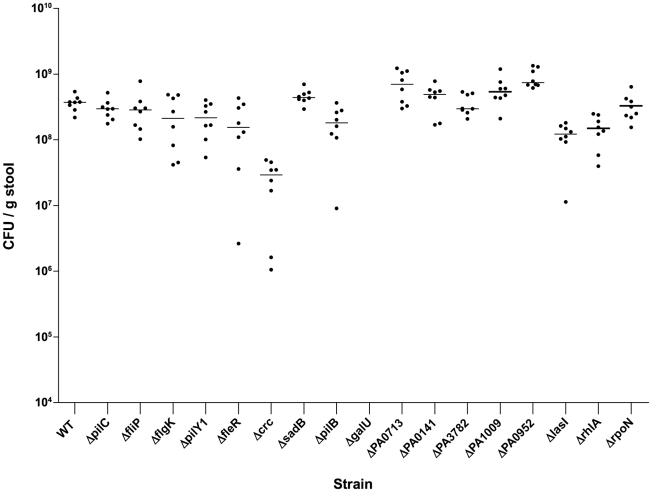
Gastrointestinal Colonization Levels Mice fed P. aeruginosa strains PA14 and the above listed PA14 transposon insertion mutants.Points represent result from individual animals (female 6–8 wk-old C3H/HeN mice), and horizontal lines represent the medians. n = 8 for each strain. Colonization levels with strain Δcrc were significantly lower (p<0.05 by Kruskal Wallis with Dunn's multiple comparison test) compared with wild-type strain PA14 (WT).